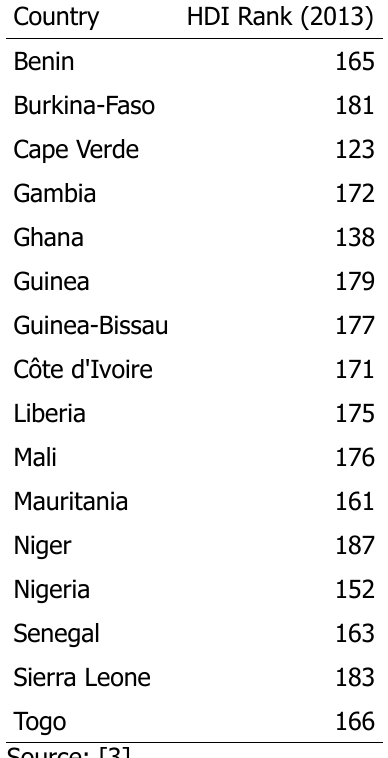
Table 2. West African countries human development index (HDI) for